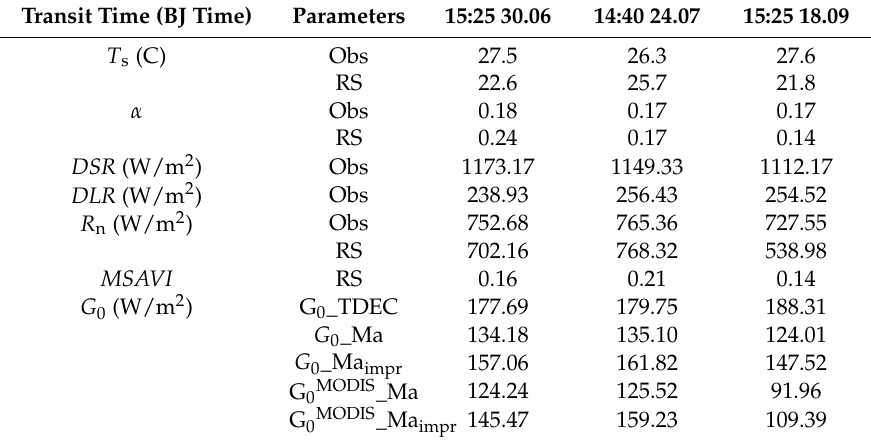
Table 9. Land surface parameters and ground surface soil heat flux G 0 inverted in the images taken at three selected times (hh:mn dd. mm) in 2014.